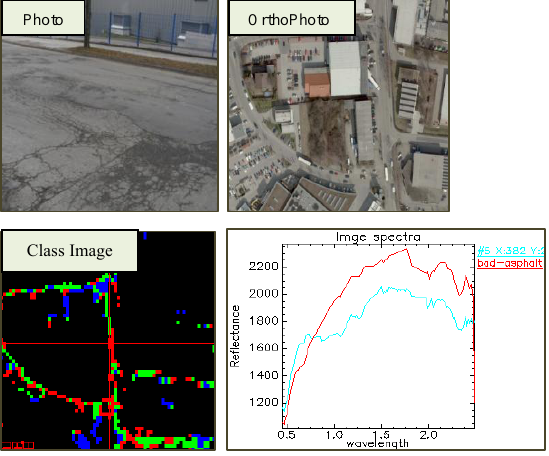
Figure 11. Assessment of classification result on